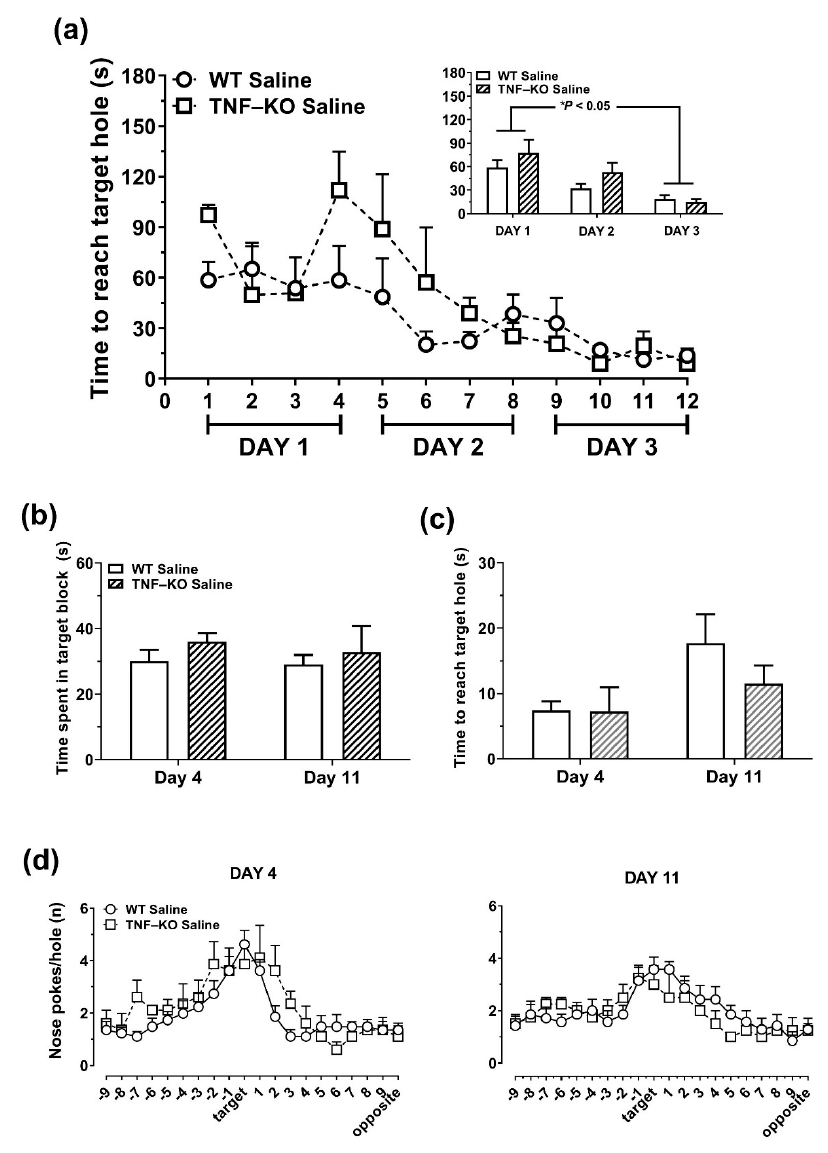
Figure 5. PBS-treated female TNF-KO mice are not impaired in the BMT. We examined whether the genetic deletion of TNF impairs BMT performance in female, PBS-treated, WT ( n = 7) and KO mice ( n = 4). ( a ) Primary latency was reduced on DAY 3 vs. DAY 1, in both WT and TNF-KO mice. ( b , c ) Time-spent in target block ( b ) and primary latency ( c ) were not different between groups during the memory probing sessions on DAYS 4 and 11. ( d ) There was no effect of genotype and time on the distribution of nose-pokes on DAYS 4 and